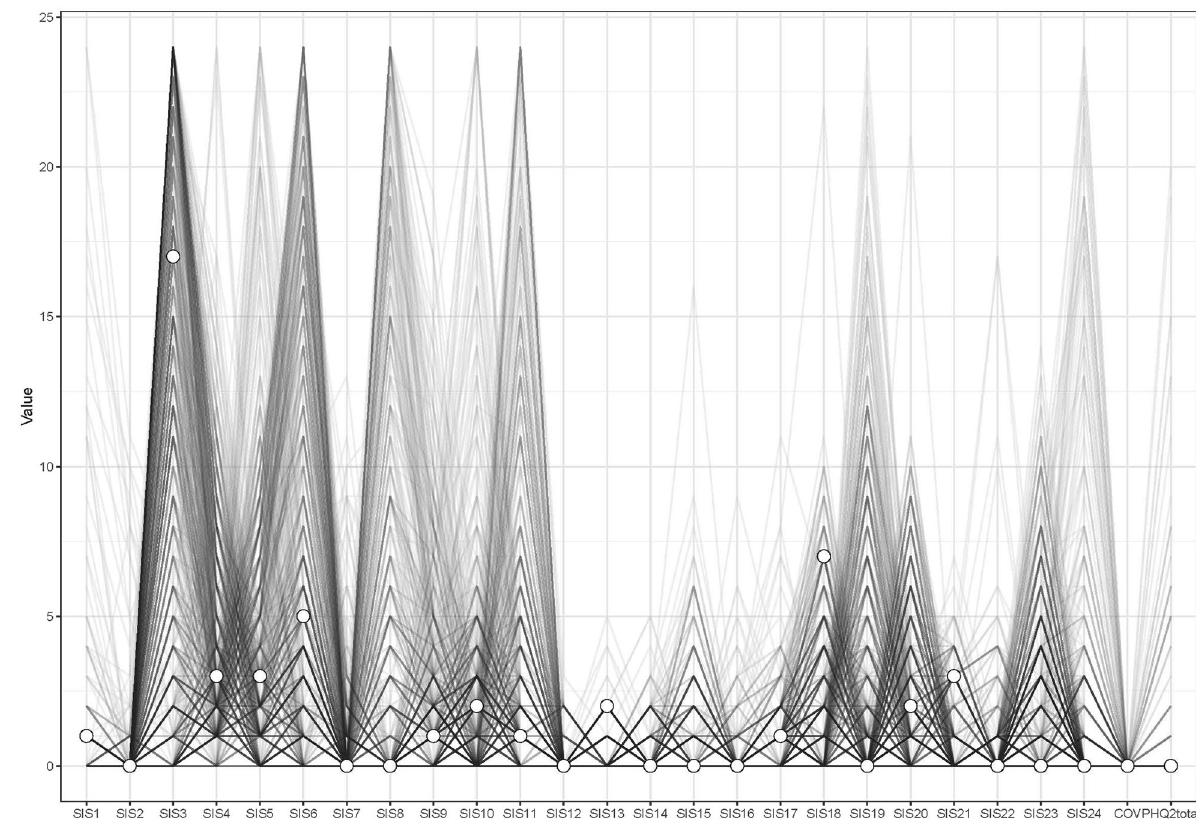
Fig. 4 Node-speci fi c predictive betweenness. The white dots represent the node-speci fi c predictive betweenness in the study sample, while the black lines represent the variability of node-speci fi c betweenness across 1000 nonparametric bootstrap